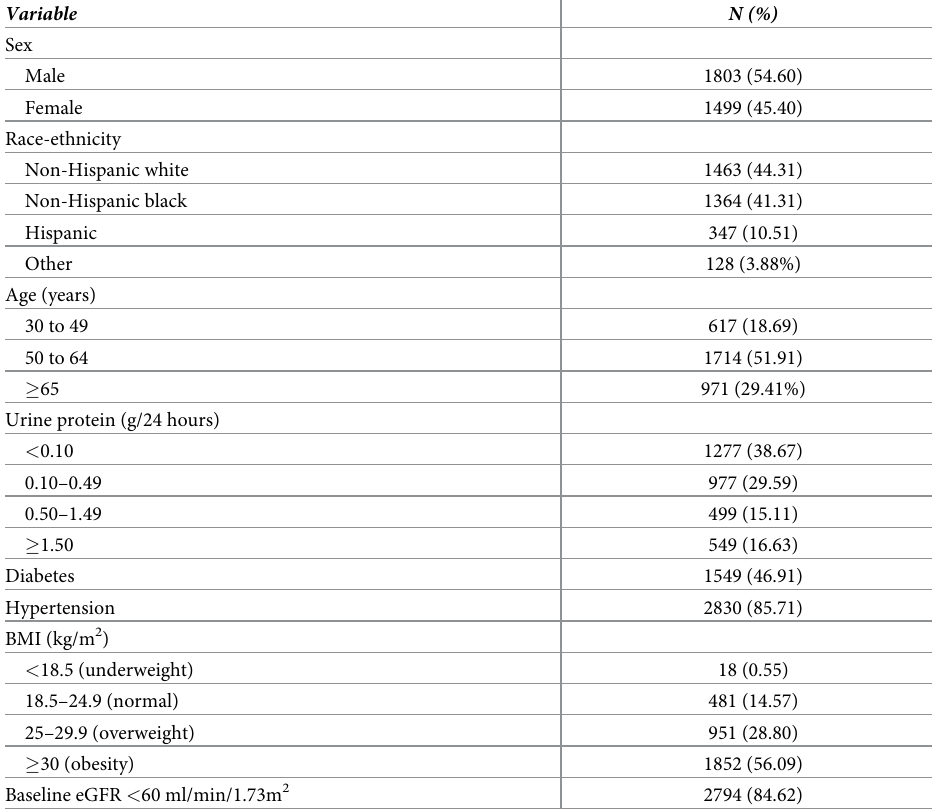
Table 1. Baseline characteristics of the Chronic Renal Insufficiency Cohort study Analytic